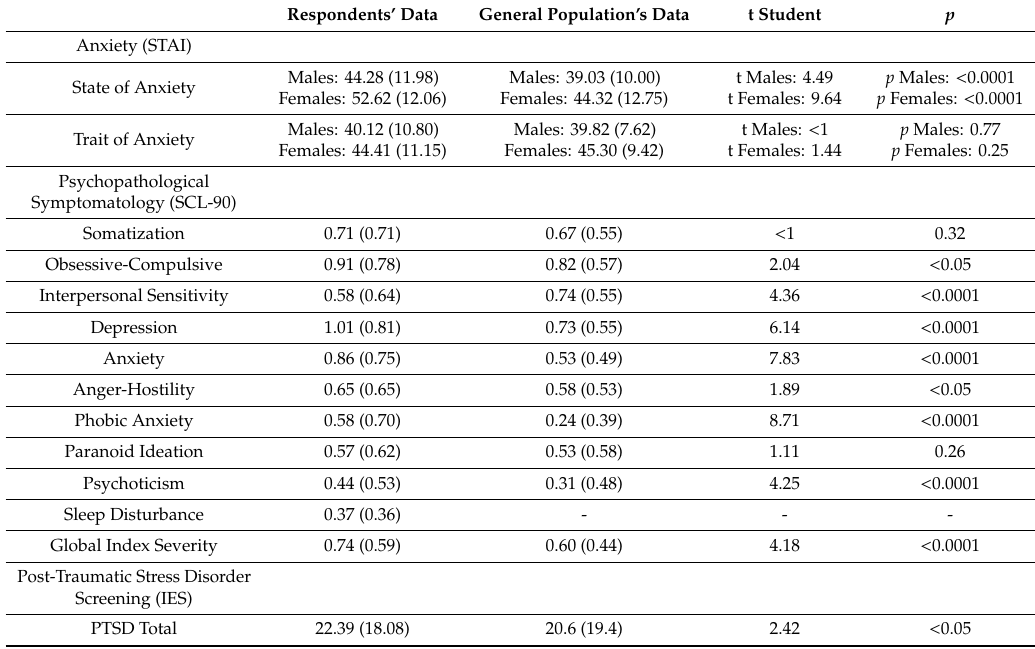
Table 2. Mean and SD of state and trait anxiety (STAI), psychopathological symptomatology (SCL-90) and post-traumatic symptomatology (IES) outcomes of the responders and comparison with data from the general population.